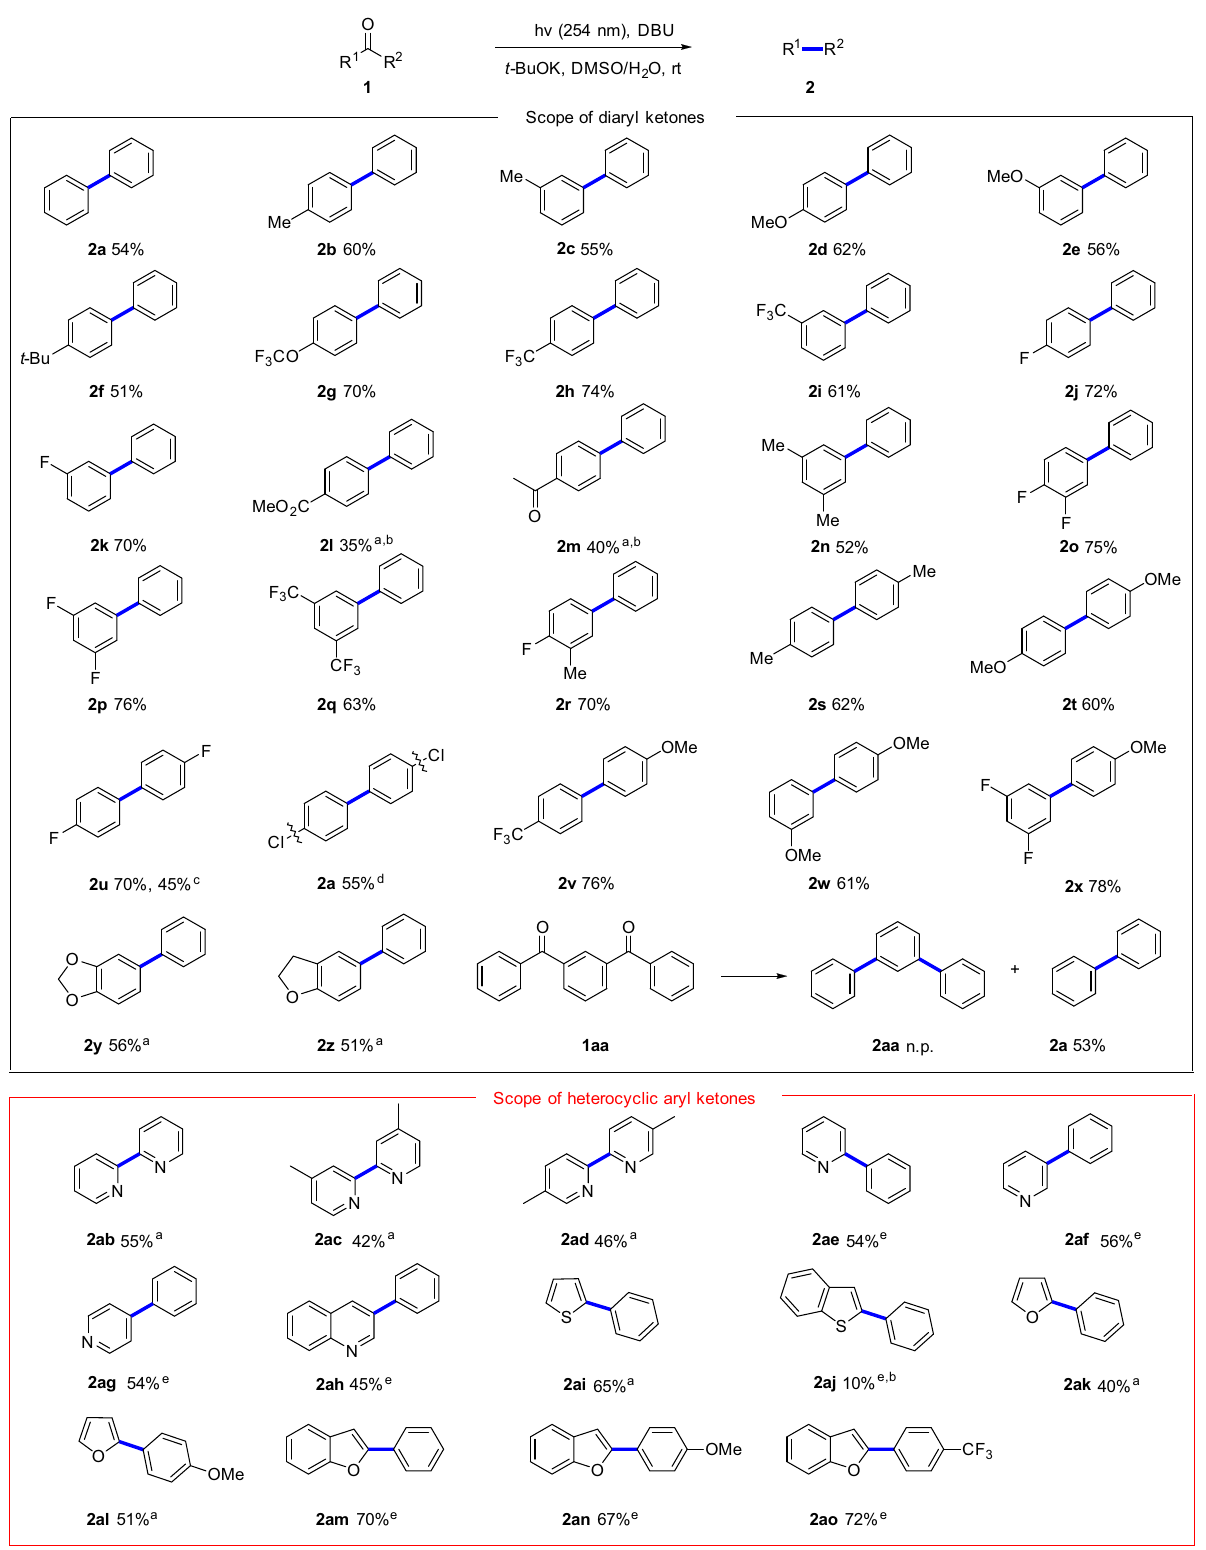
Fig. 2 Substrate scope of the decarbonylation reaction. General conditions: 1 (0.1 mmol), DBU (2 equiv.), t -BuOK (1.25 equiv.) in DMSO (1.5 mL), H 2 O (80 μ L) at rt for 36 h under Ar; a Without H 2 O. b 48 h. c The reaction was carried out on a 6.0 mmol scale under modi fi ed conditions (see Supplemental Information). d Dechlorination product 2a was obtained. e NaOH (1.25 equiv) instead of t -BuOK, without H 2